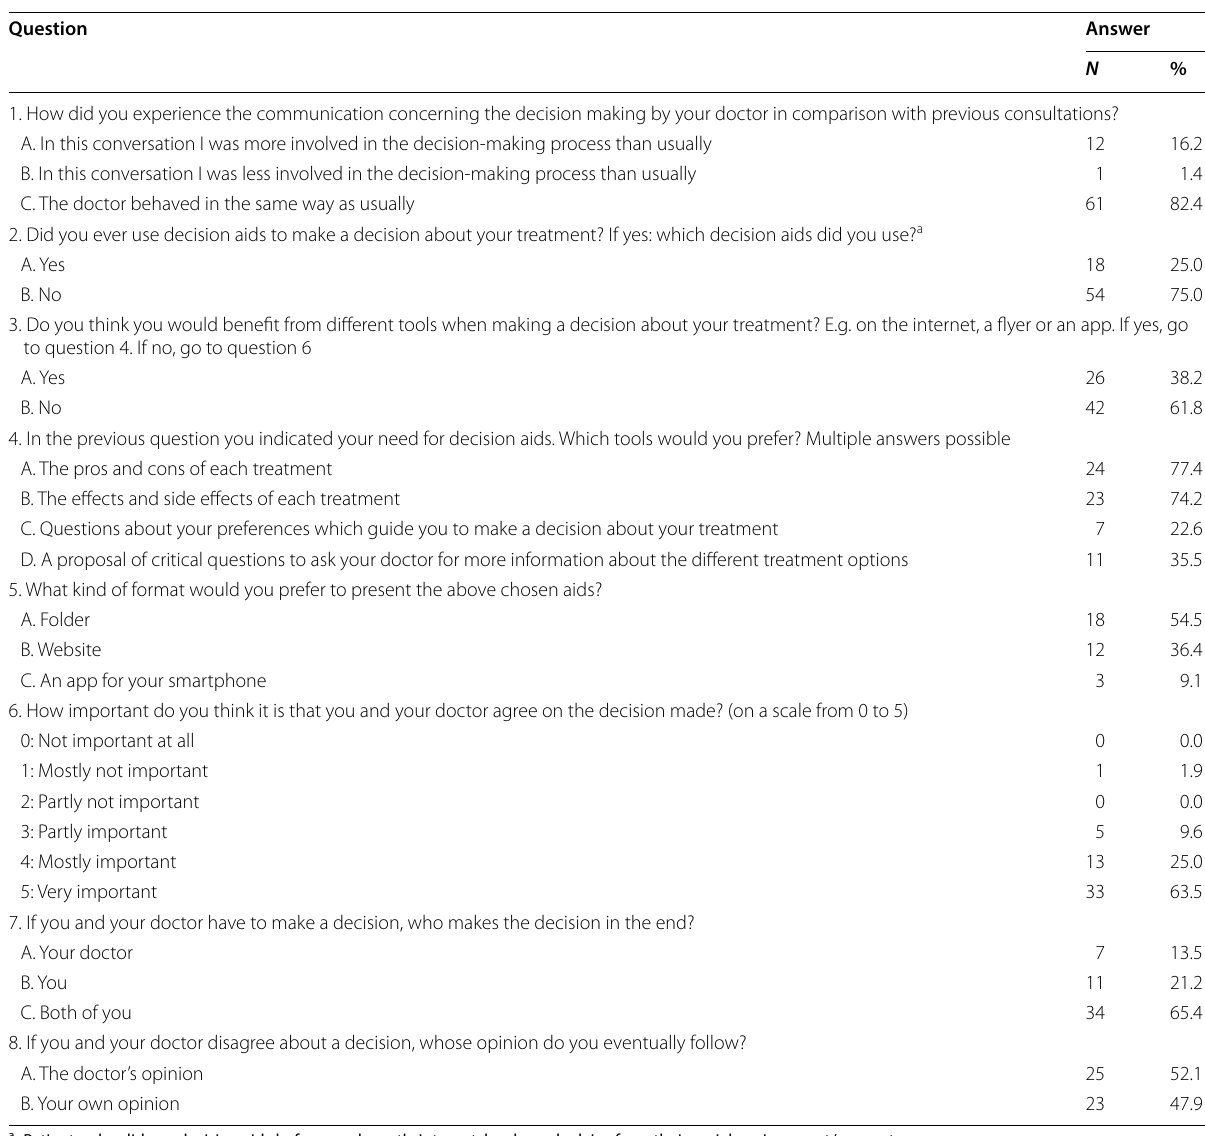
Table 3 Patients’ answers to multiple choice questions in the qualitative interview